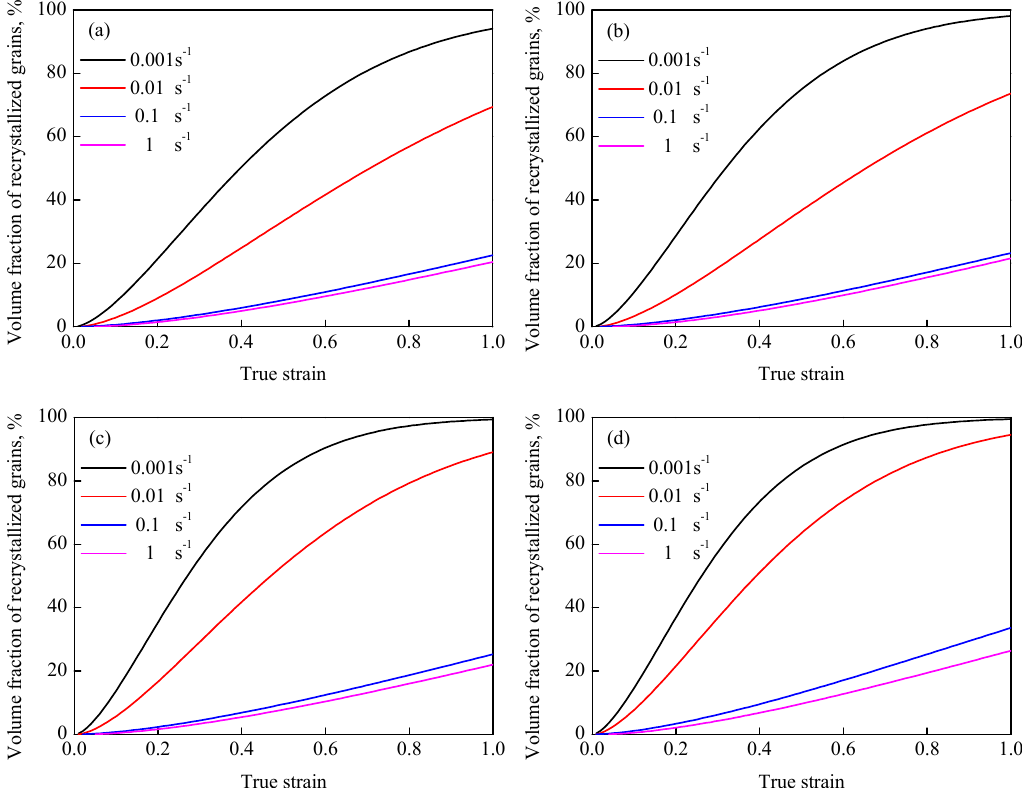
Figure 15. Variation in the X DRX with true strain at different temperatures of ( a ) 850 ° C, ( b ) 900 ° C, ( c ) 950 ° C and ( d ) 1000 ° C.